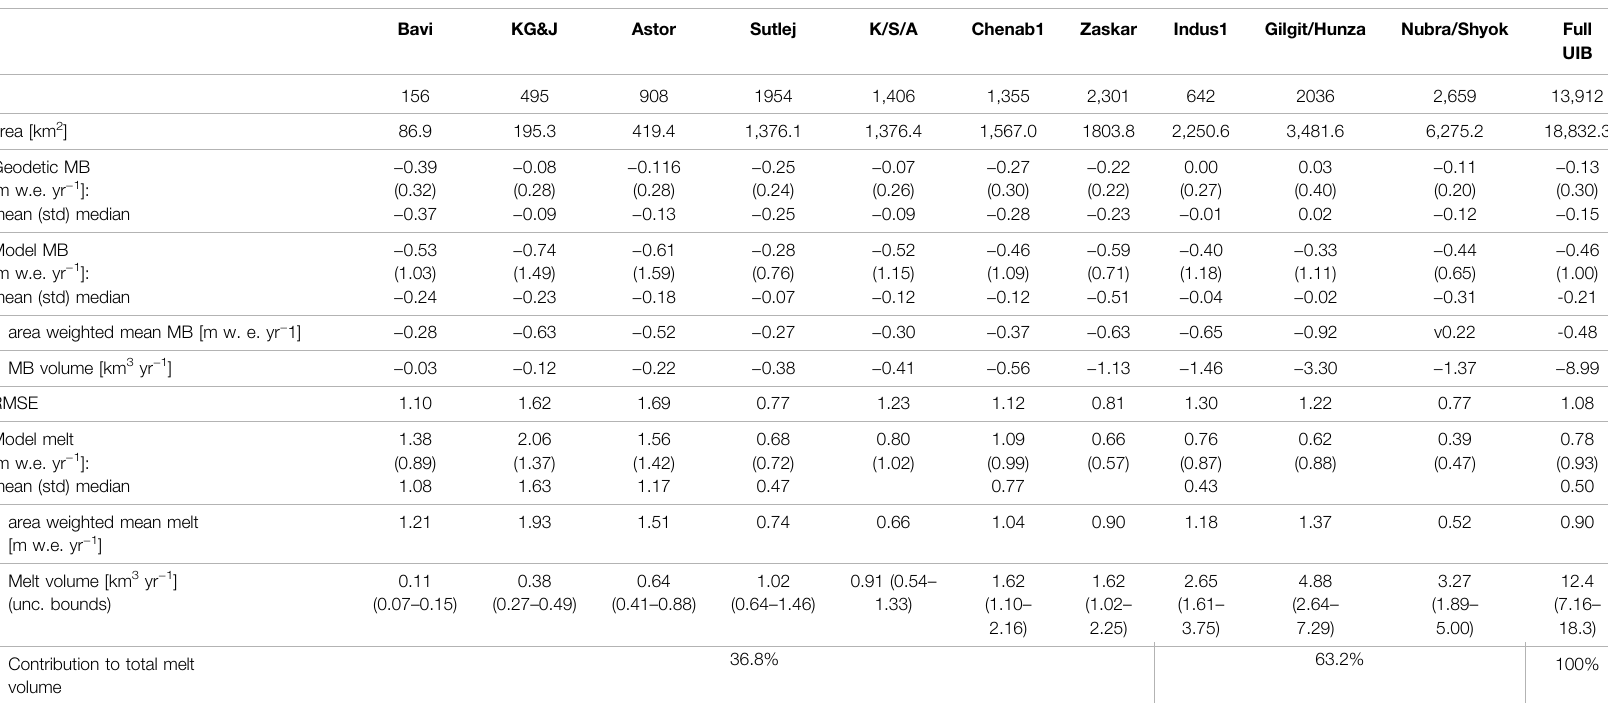
TABLE2| Results ofthesurfaceenergyandmassbalancemodelrunoverallsubbasinsoftheUpperIndusBasin2001 – 2013,withgeodeticmassbalance(MB)from2001 – 2018(Sheanetal.,2020).Subbasinsareordered by increasing area to match the order in Figure 5 . The average MB and melt are given, as well as corresponding melt volumes and area-weighted means. The RMSE is calculated by comparing a subbasin ’ s